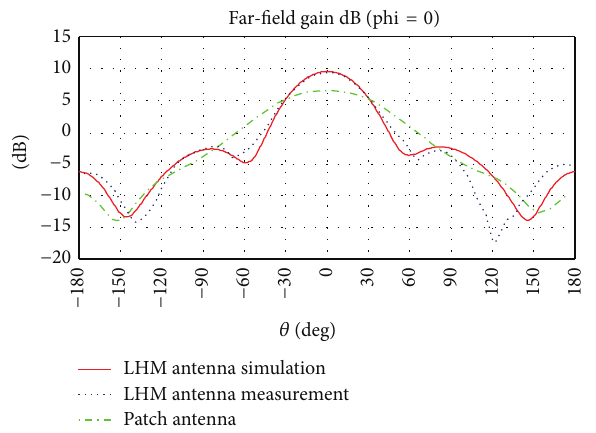
Figure 18: Radiation pattern of fabricated FL-LHM antenna in simulation and measurement.